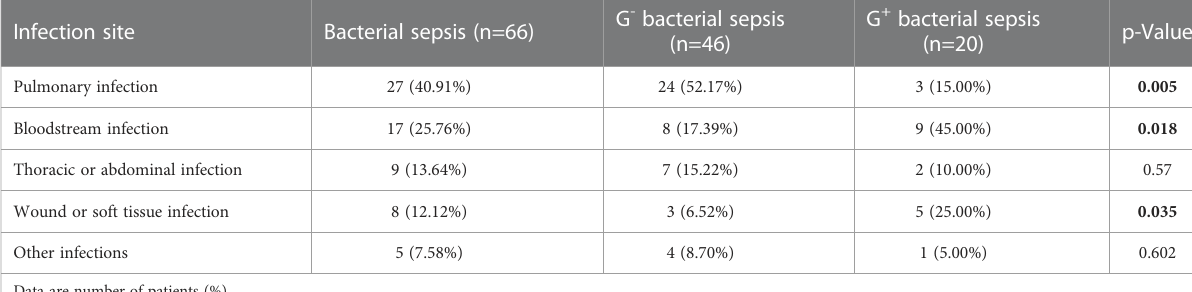
TABLE 2 Infection site of sepsis